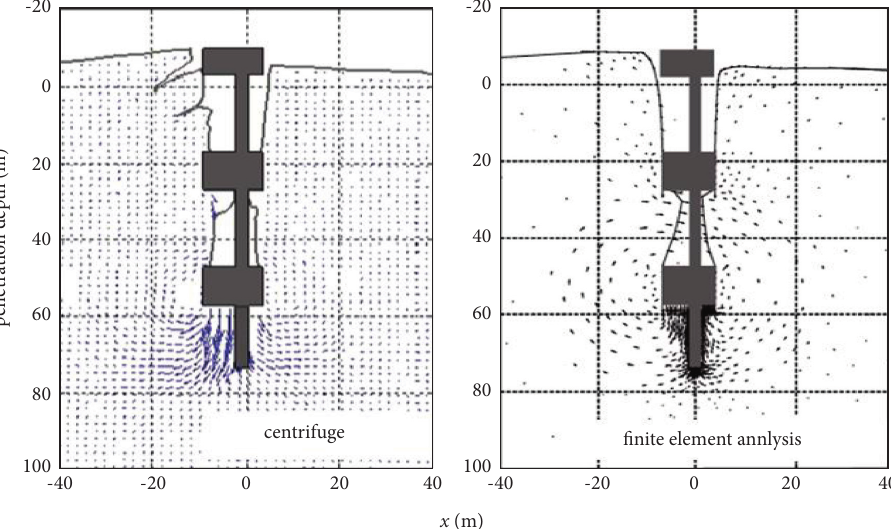
Figure 5: Validation in terms of soil movement.